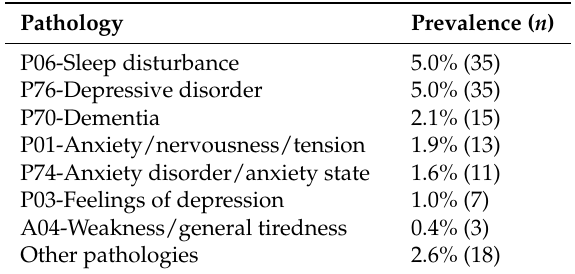
Table 2. Prevalence of coded pathologies recorded in the clinical records of the patients that potentially indicated the need for benzodiazepine